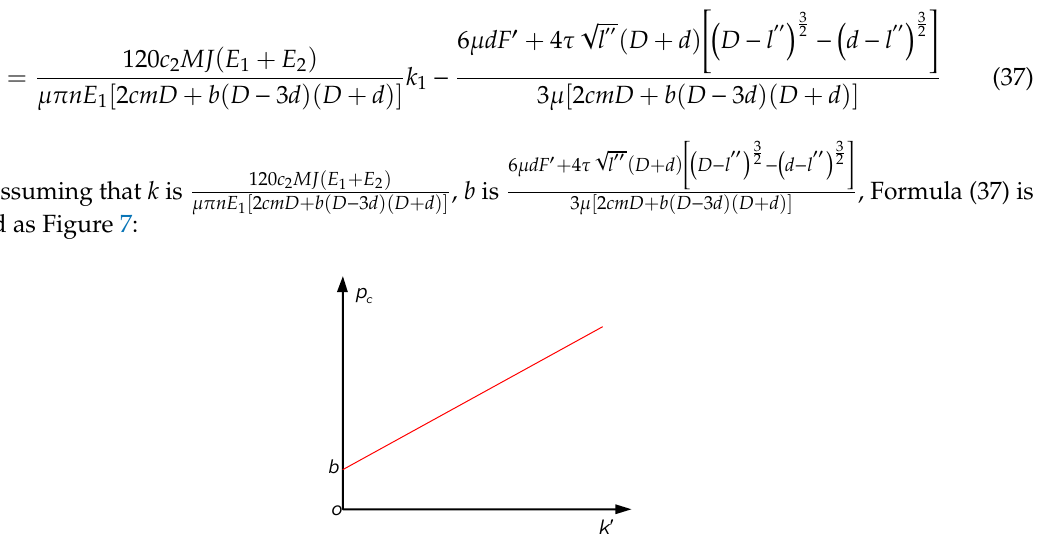
plotted as Figure 7: